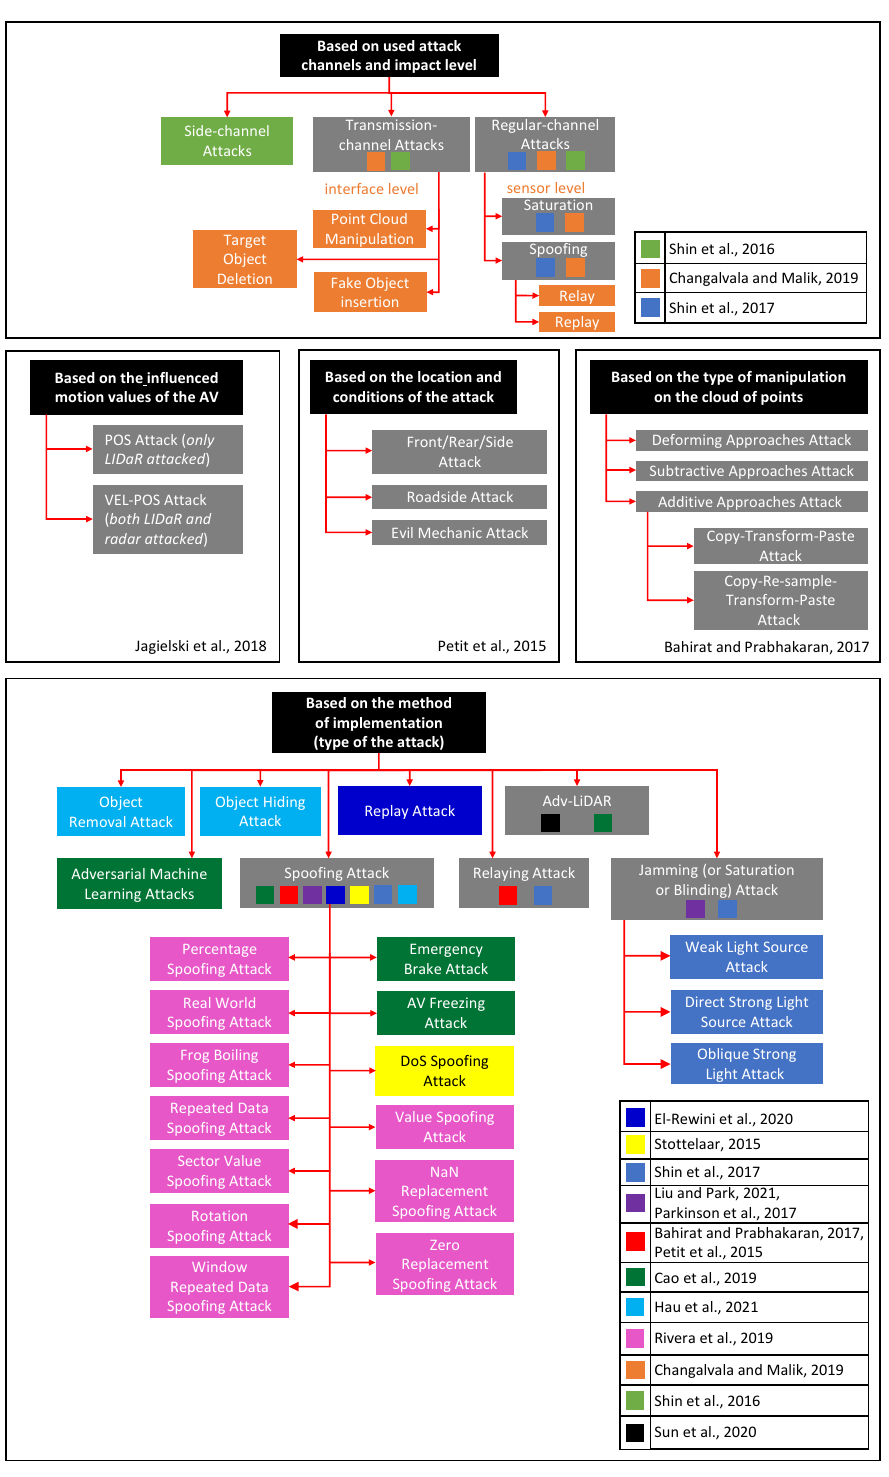
Figure 1. Approaches to classifying the attacks on automotive LiDARs.